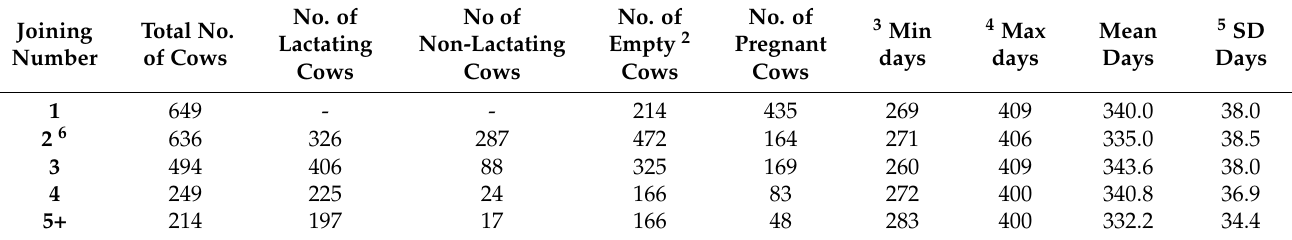
Table 1. Summary (min, max, mean, SD) of adjusted 1 days to calving over